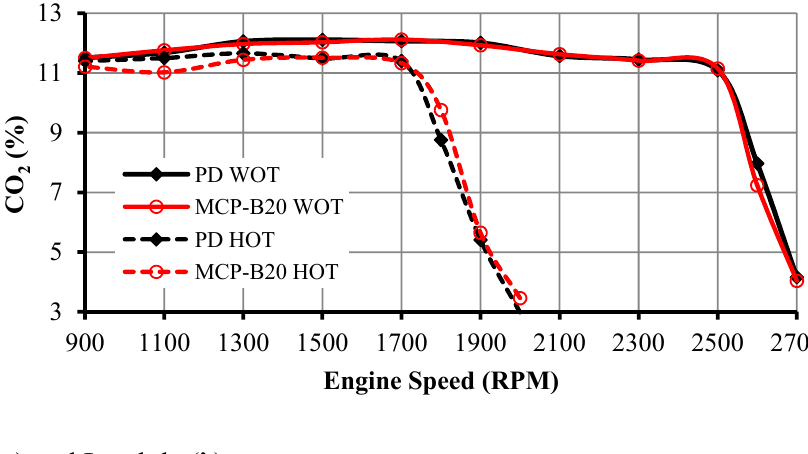
Figure 11. The relationship between tractor engine speeds (RPM) and CO and